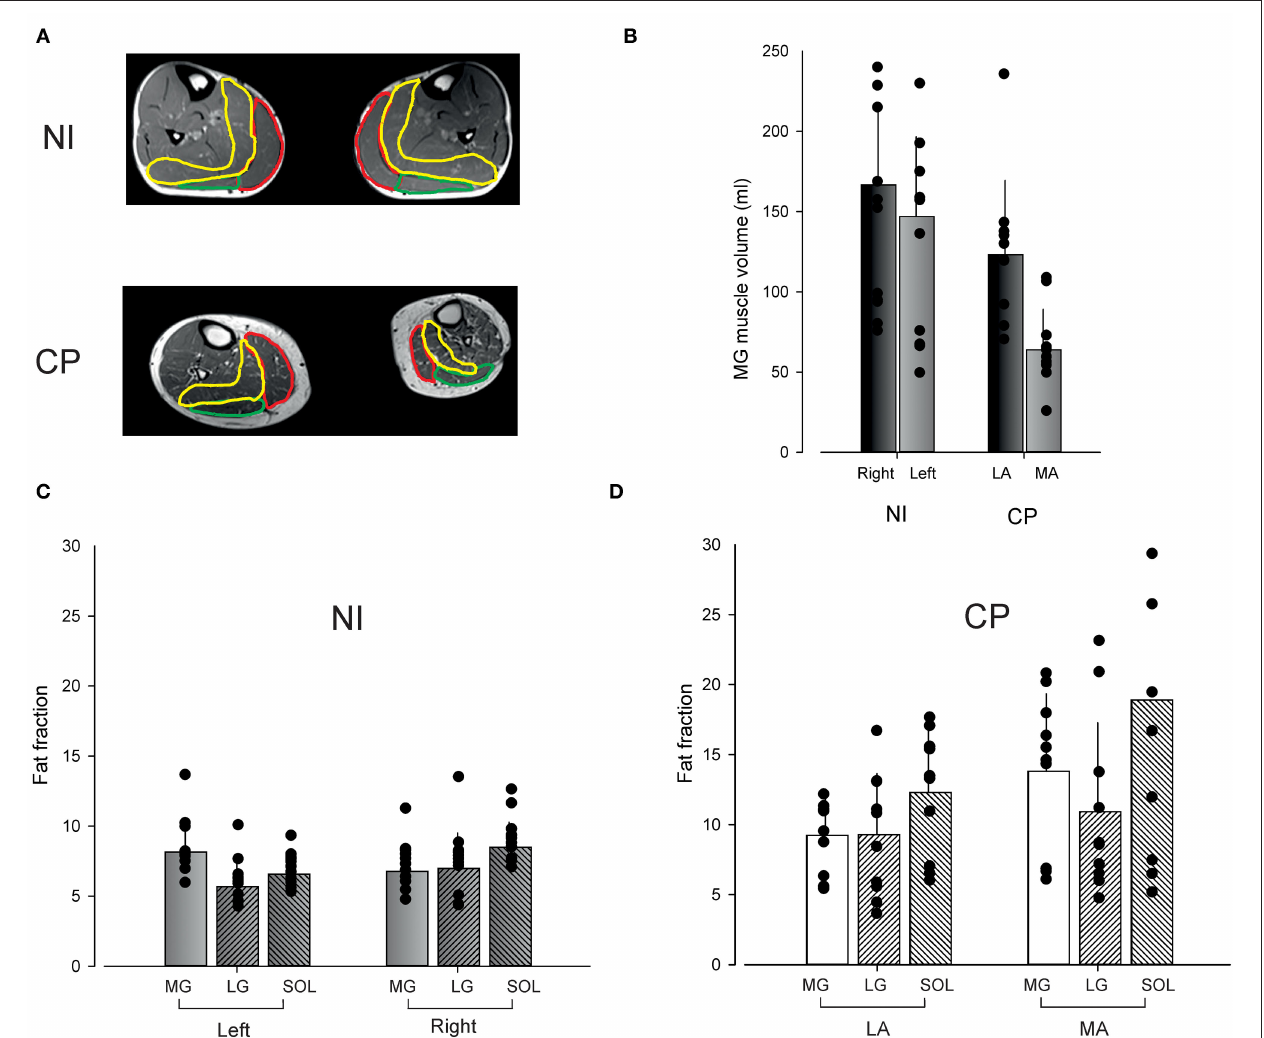
FIGURE 1 | Muscle volume and composition. Muscle volume and intramuscular fat fraction in neurologically intact adults (NI) and adults with Cerebral Palsy (CP) measured by MR. (A) Shows examples of scans from an NI individual and an individual with CP. The medial gastrocnemius muscle has been marked in red, the lateral gastrocnemius muscle in green and the soleus muscle in yellow. (B) Shows the medial gastrocnemius muscle volume on the most affected side in adults with CP and on the right side in NI adults. (C) Shows the calculated fat fraction for each of the three triceps surae muscles on the left and right side in NI adults. (D) Shows the fat fraction for adults with CP for their least affected (LA) and most affected (MA) leg. Bars show the average fat fraction with vertical lines depicting standard deviations. Data from individual subjects have been superimposed as black circles on top of each of the